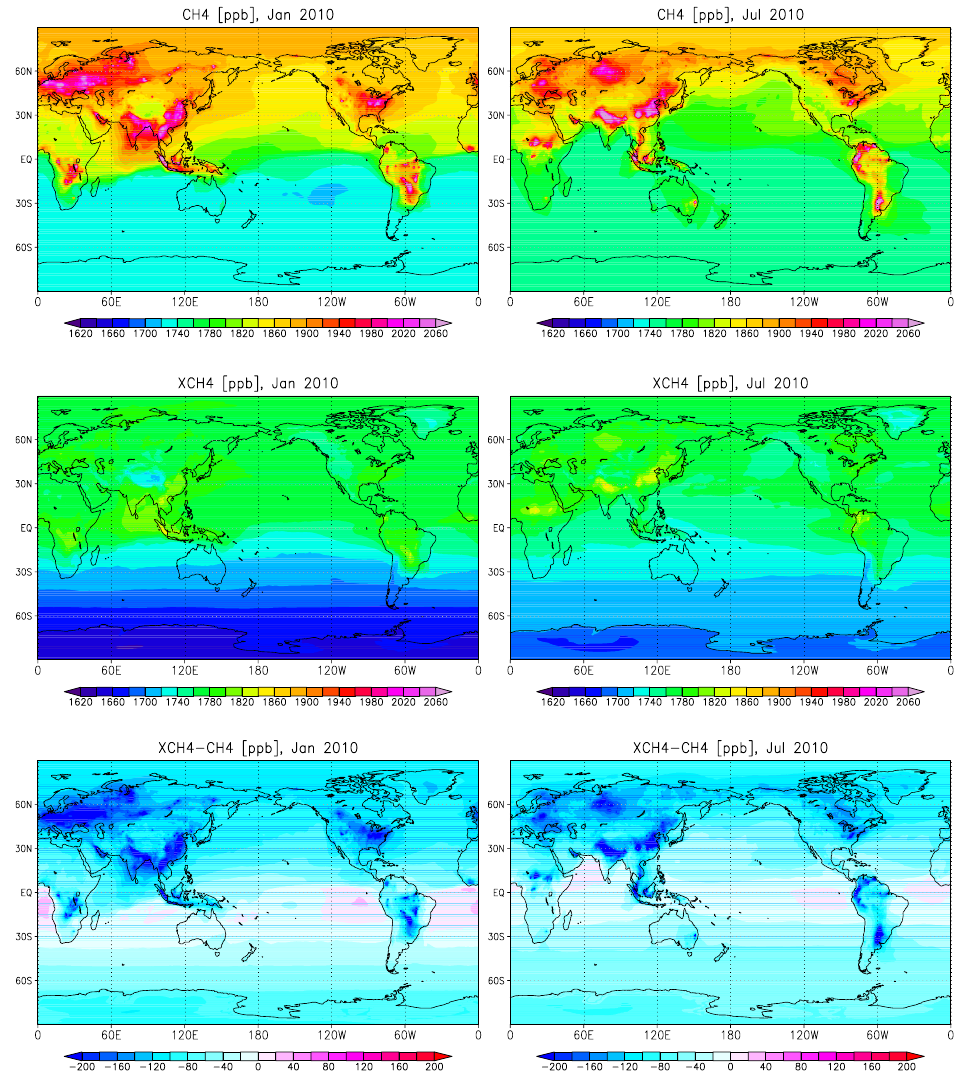
Fig. 10. Same as Fig. 7, but for CH 4 , XCH 4 , and their differences. Ranges of colour scales are 1620–2060ppb for CH 4 and XCH 4 , and − 200 to 200ppb for the